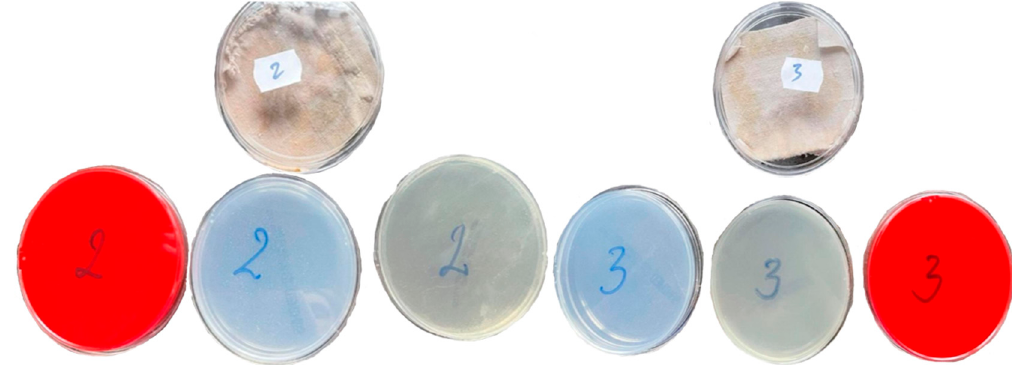
Figure 5. Culture plates after NNPSAg treatment of samples 2 and